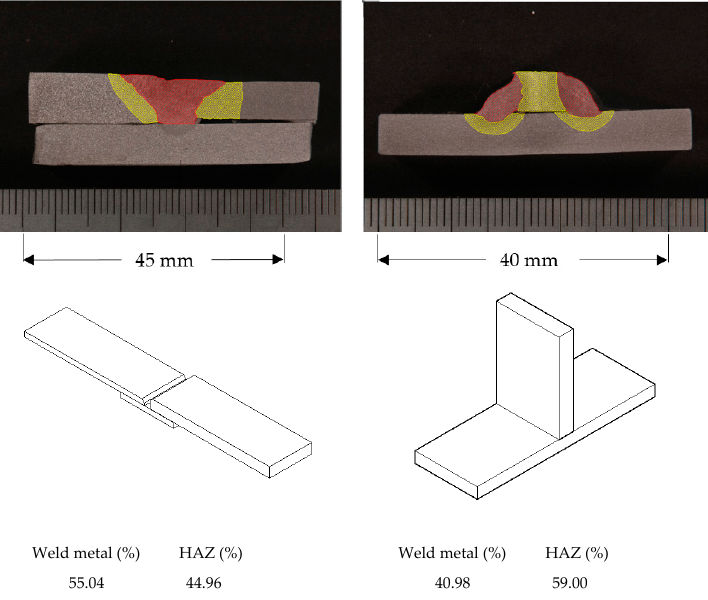
Figure 4. Measurement of the Heat-Affected Zone (HAZ) size and average of relative areas of weld metal and HAZ. ( a ) Complete butt penetration welded joint. ( b ) Opposed twin fillet welded joint.